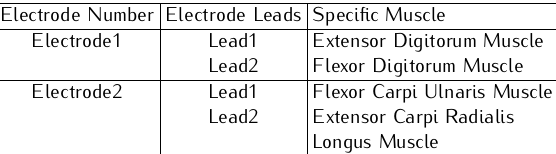
Table 2. Placement of EMG